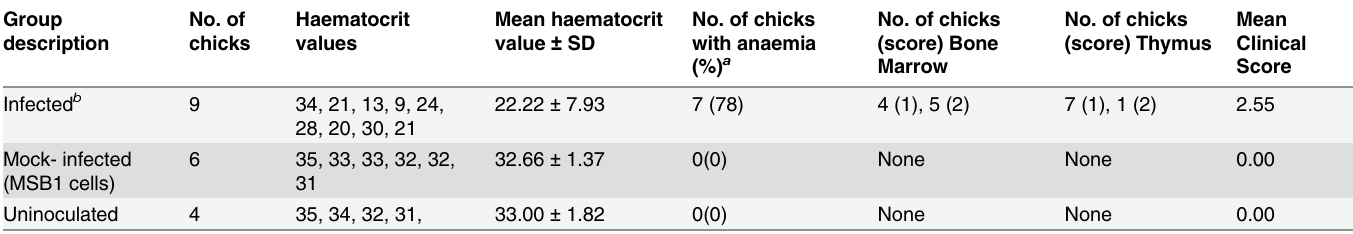
Table 1. Pathogenicity evaluations of infected, uninfected and mock-infected animals at day 14 post-infection. Gross pathological examination of the thymuses and bone marrows was performed in a blind manner, and a clinical score was estimated by scoring the severity of the thymus atrophy and pale- ness of the bone marrow, as 0, 1 or